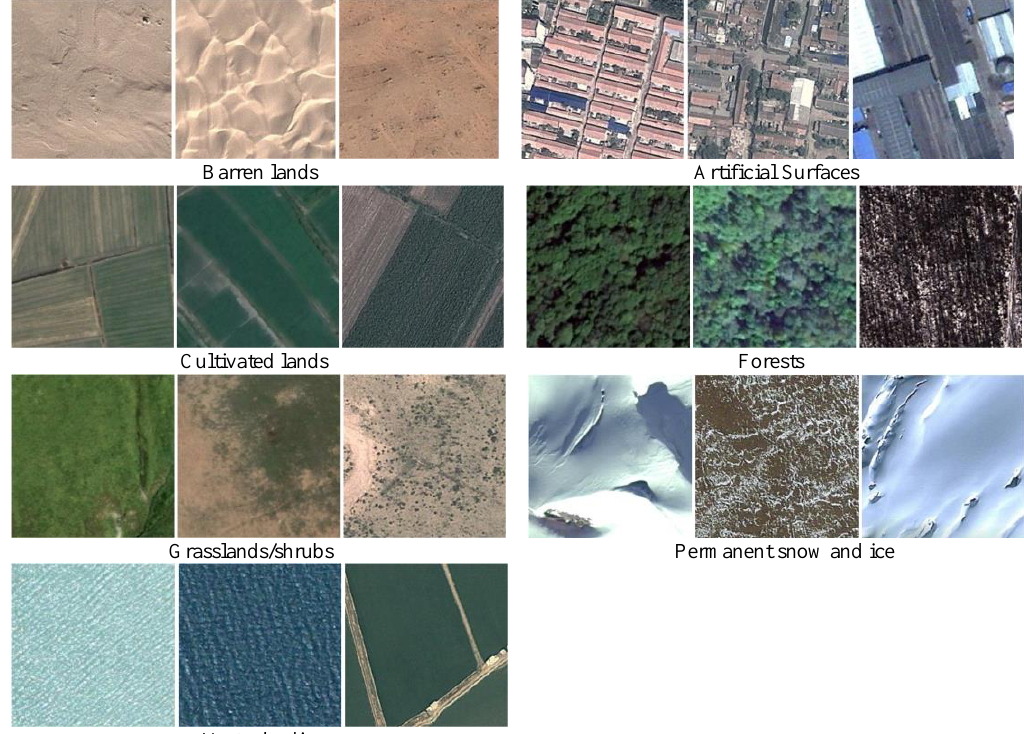
Figure 3. Sample set obtained in this paper: three examples of each class. There are more than 10, 000 images in each category computation process requiring days or even weeks. Fortunately,